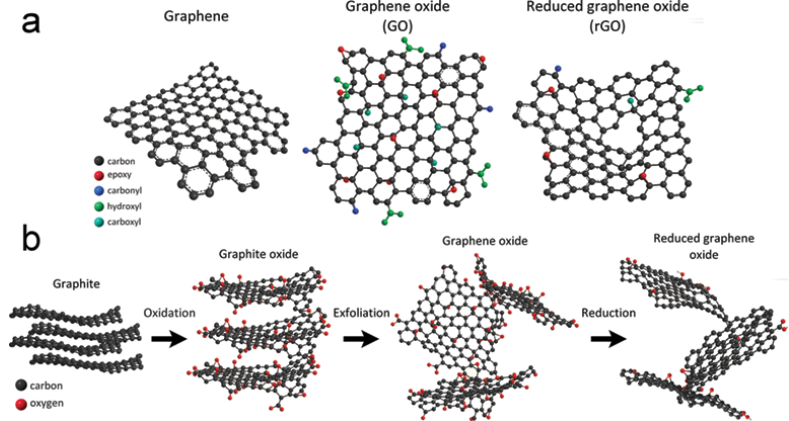
Figure 2. ( a ) Chemical structure of graphene (G), graphene oxide (GO), and reduced graphene oxide (rGO) and ( b ) route of graphite to reduce graphene oxide.(Reproduced or adapted from ref. [20], with permission from Intech, 2016).